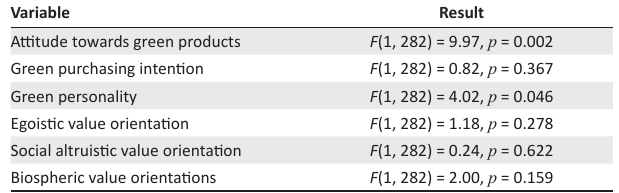
TABLE 1: Reliability test results.